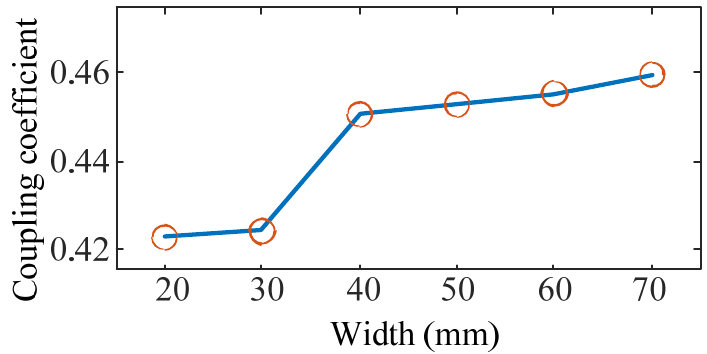
Figure 12. Coupling coefficient waveform with different widths.